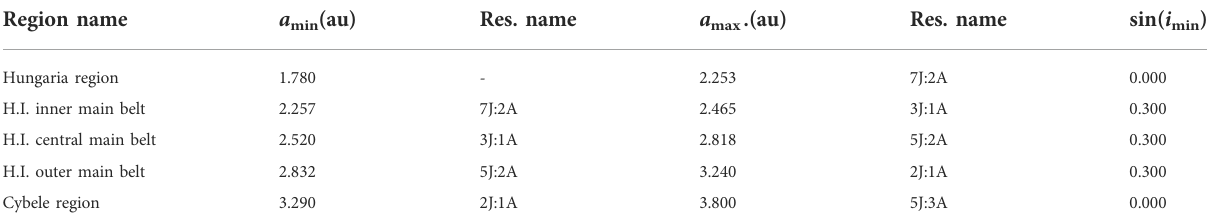
TABLE 1 Table of the main belt orbital regions. We report the region name, where H.I. indicates for highly inclined, the a min value and the Jupiter mean-motion resonance name associated with that value, a max value and its related Jupiter mean-motion resonance name, and the minimum value of sin( i min ).